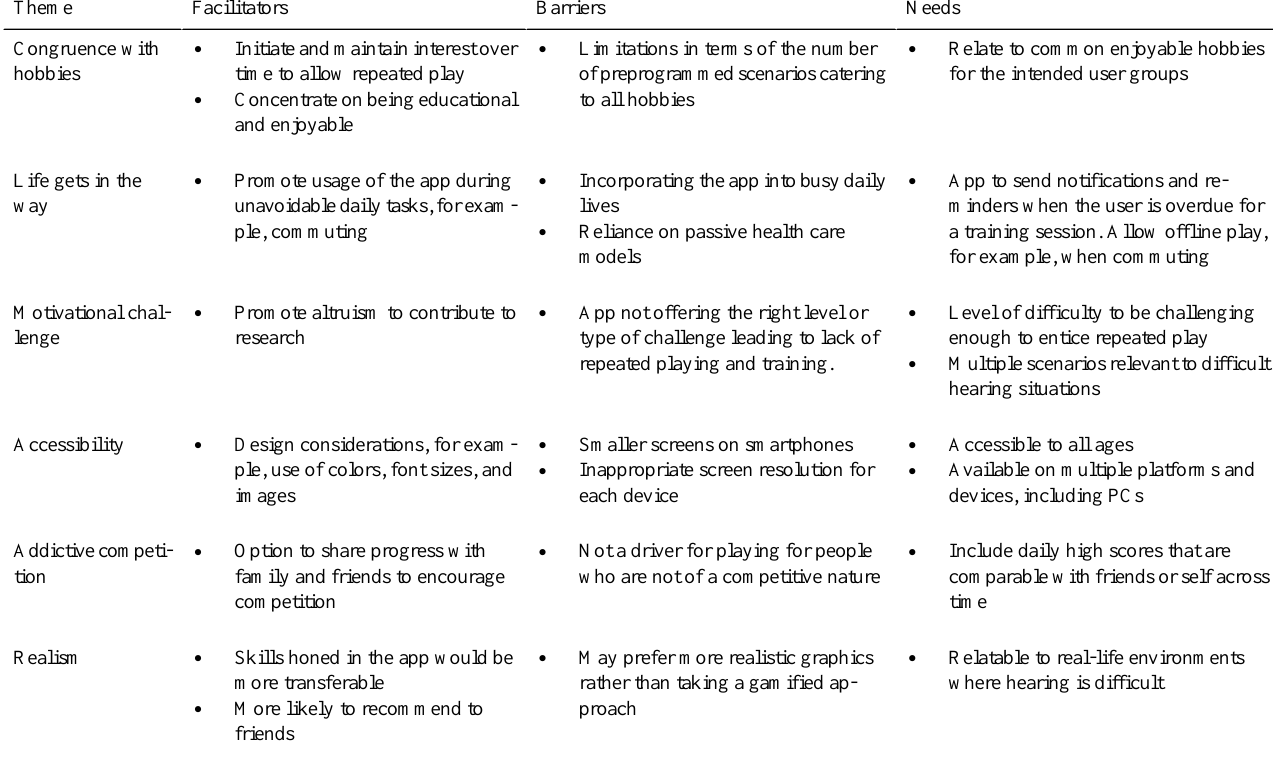
Table 2. Summary of findings in relation to the research